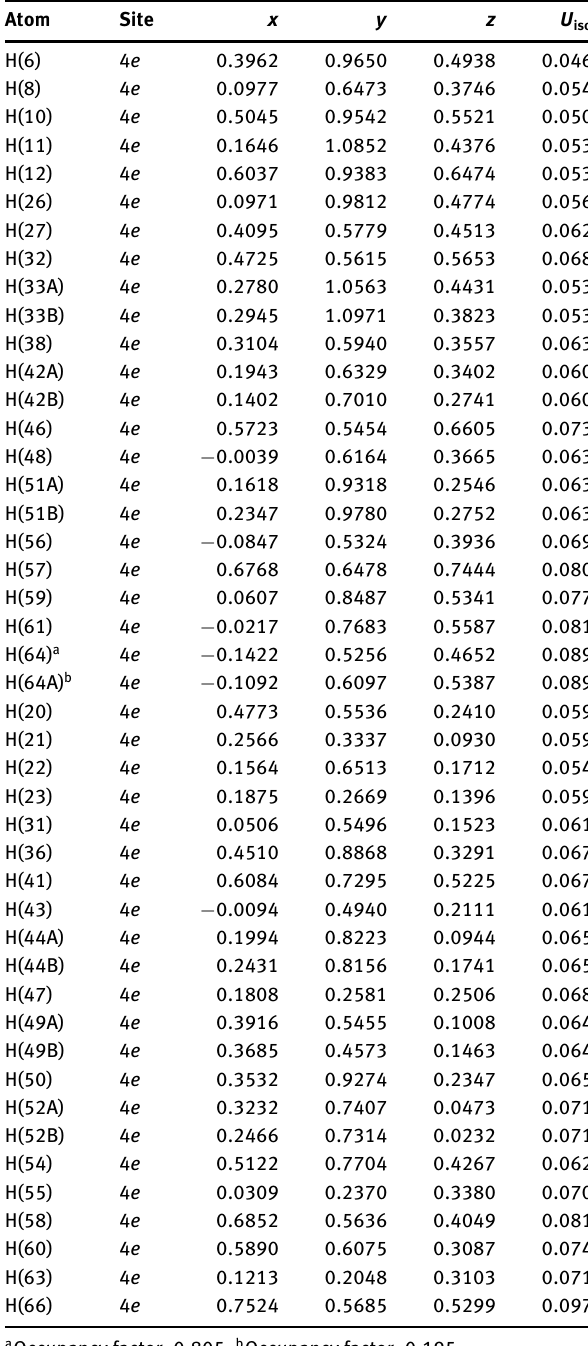
Table 2: Fractional atomic coordinates and isotropic or equivalent isotropic displacement parameters (Å 2